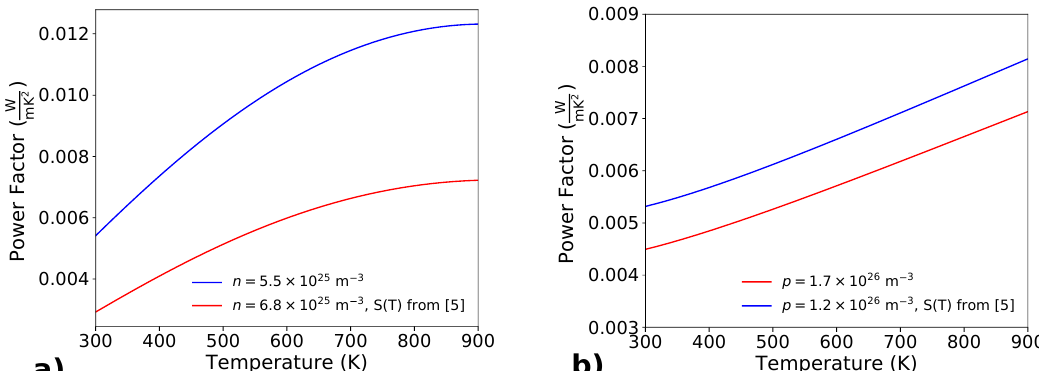
Figure 3. The power factor of n (Panel ( a )) and p (Panel ( b )) doped silicon is reported as a function of temperature. The blue curves concern the doping concentration, which maximizes the power factor at room temperature, the red curves have been calculated considering S = S ( T ) experimentally determined by Ohishi [12] for doping concentrations different from that for the maximum power